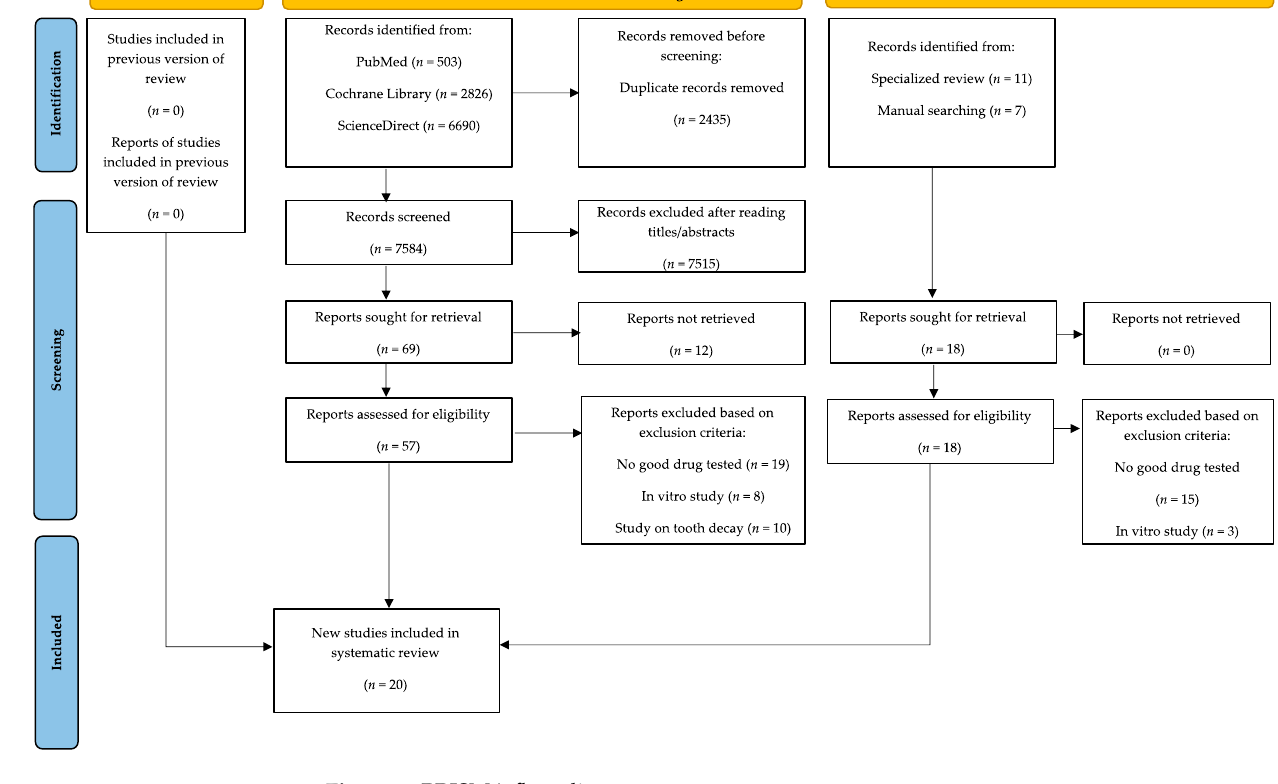
Figure 1. PRISMA flow diagram.